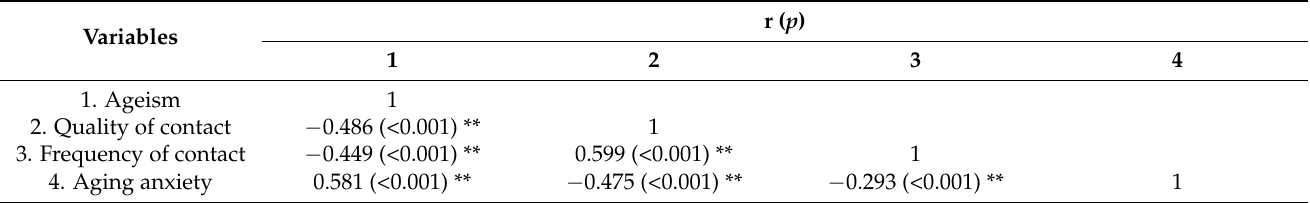
Table 4. Correlations between ageism, quality and frequency of contact experience, and aging anxiety ( N = 238).